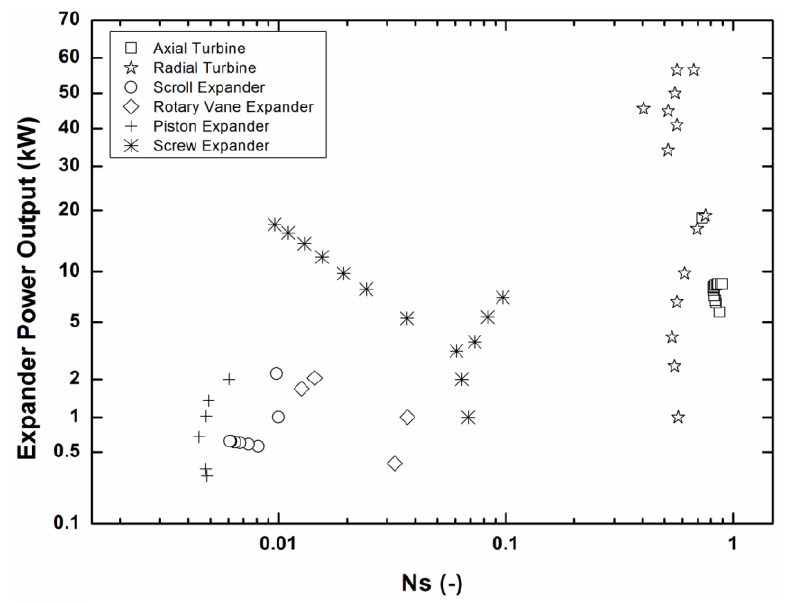
Figure 13. Expander power vs. specific speed for different expanders.